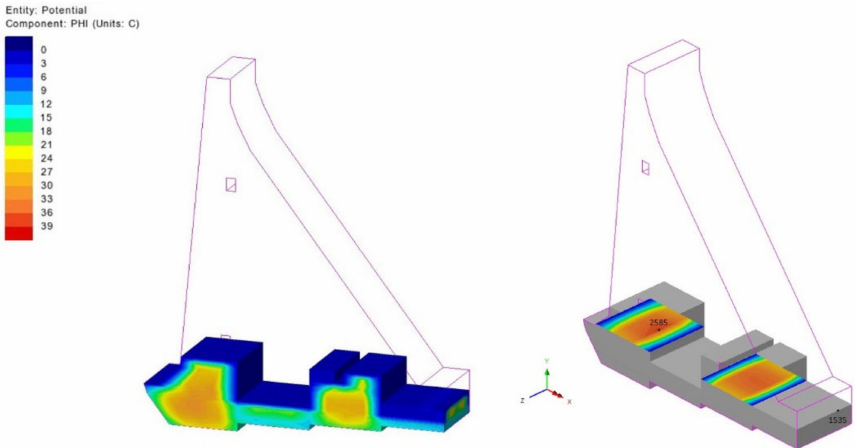
Figure 14. Temperature field for day 84 (10th of January of the second year) with horizontal cross- section at 146.50 masl; maximum: node 2585, minimum: node 1535.